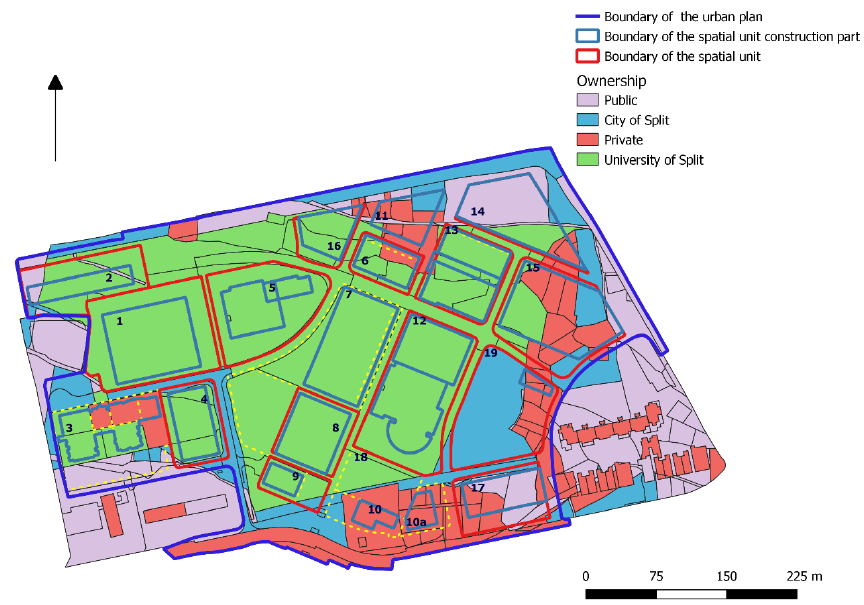
Figure 4. Urban development plan with a description of ownership of the project area of Campus, University of Split.